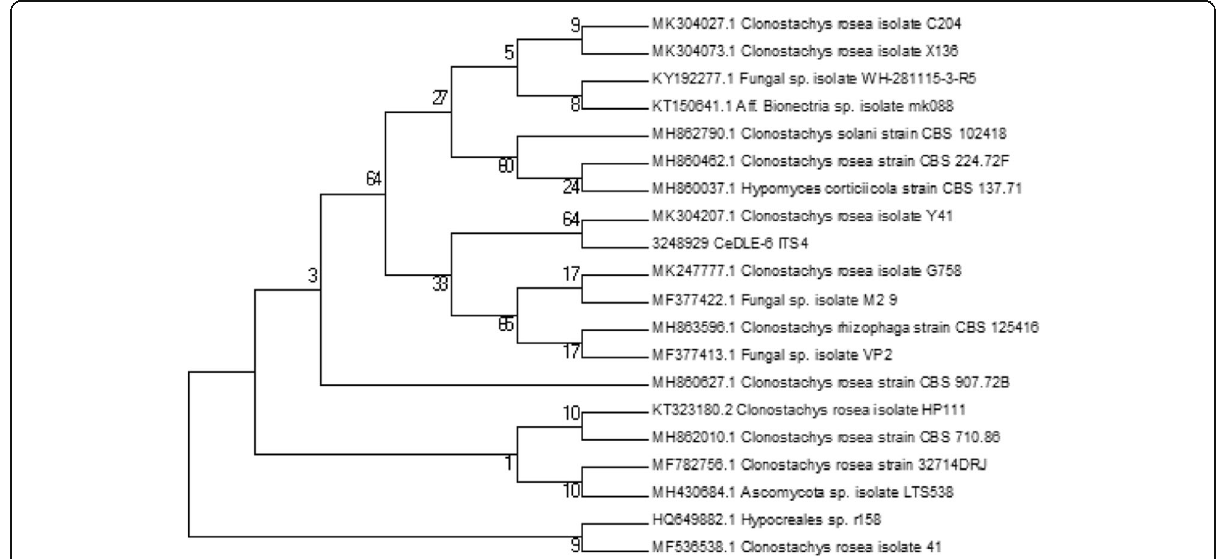
Fig. 5 Phylogenetic relationship for 5.8S-rRNA-ITS regions between the endophytic fungus CEDLE-6 and published data. Phylogenetic tree constructed using Neighbor-Joining (NJ) method with bootstrap support based on 1,000 replicates, and evolutionary distances computed using the Maximum Composite Likelihood method based on 5.8S-rRNA-ITS